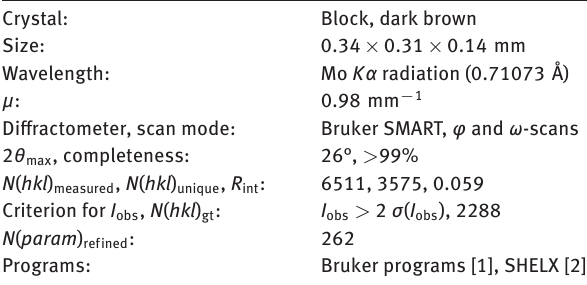
Table 1: Data collection and